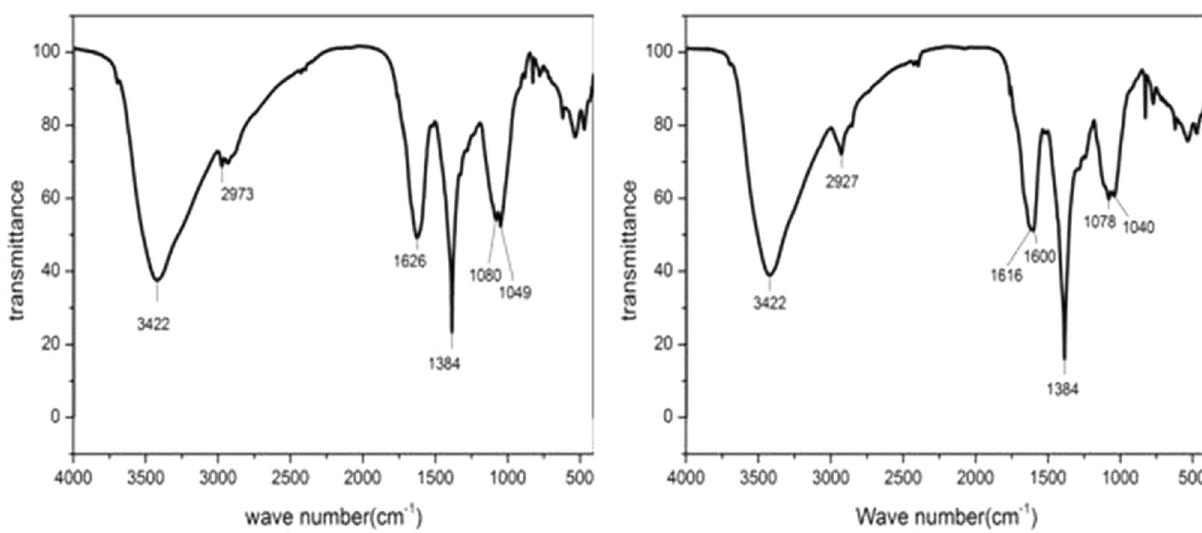
Figure 4. FTIR spectrum of madder aqueous extraction (left) and madder ethyl alcohol extraction